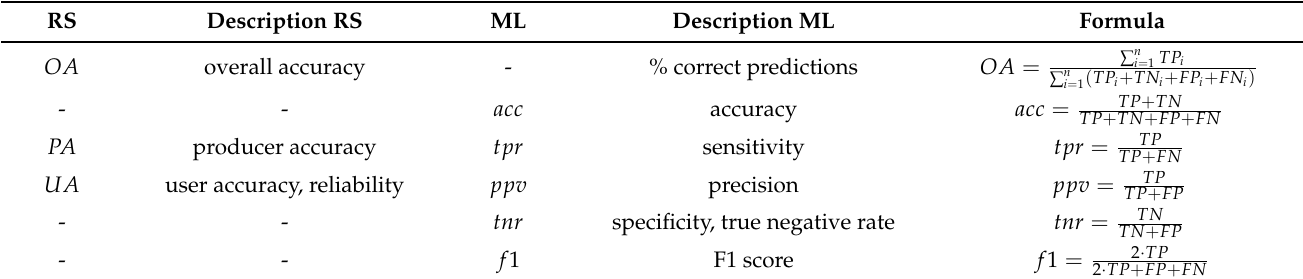
Table 4. Selected accuracy indicators calculated for each class separately except OA [30,38].